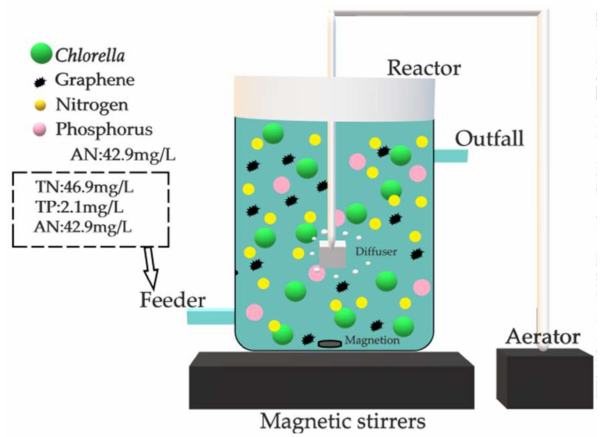
Figure 1. Schematic diagram of the